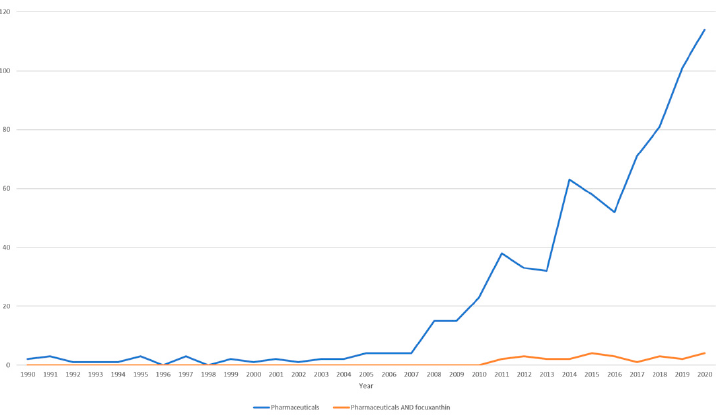
Figure 2. Documents by year for “pharmaceuticals” and “pharmaceuticals and Fucoxanthin” (Appendix B—i) (The superscript numbers listed below the figures refer to the search terms as mentioned in Appendix B).